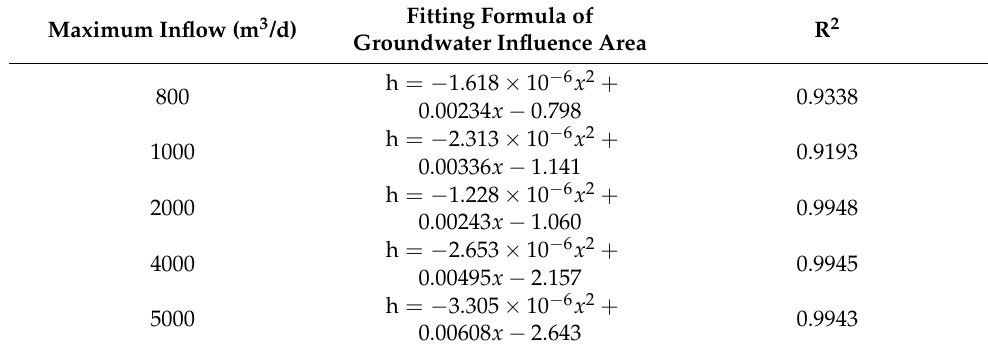
Table 4. Fitting formula of the range to which groundwater was